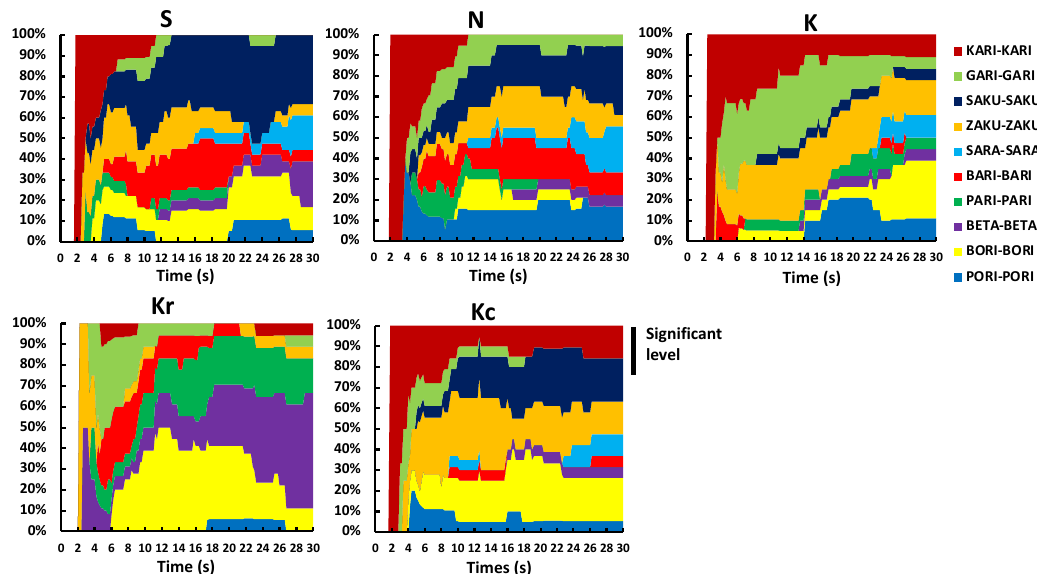
Figure 2. TDS band plots for each sample in Experiment 1. Samples S, K, and N are available commercially and produced by different manufactures. Sample Kr was a moisturized and re-dried version of K, and Kc was a crushed version of K. TDS, temporal dominance of sensations.